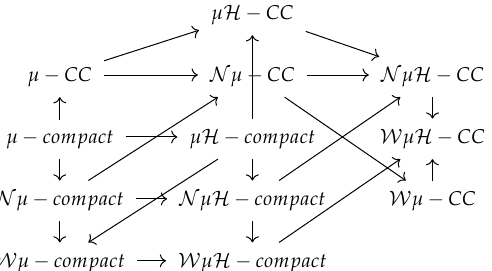
Figure 1. The relationship between all types of generalization of µ -compact